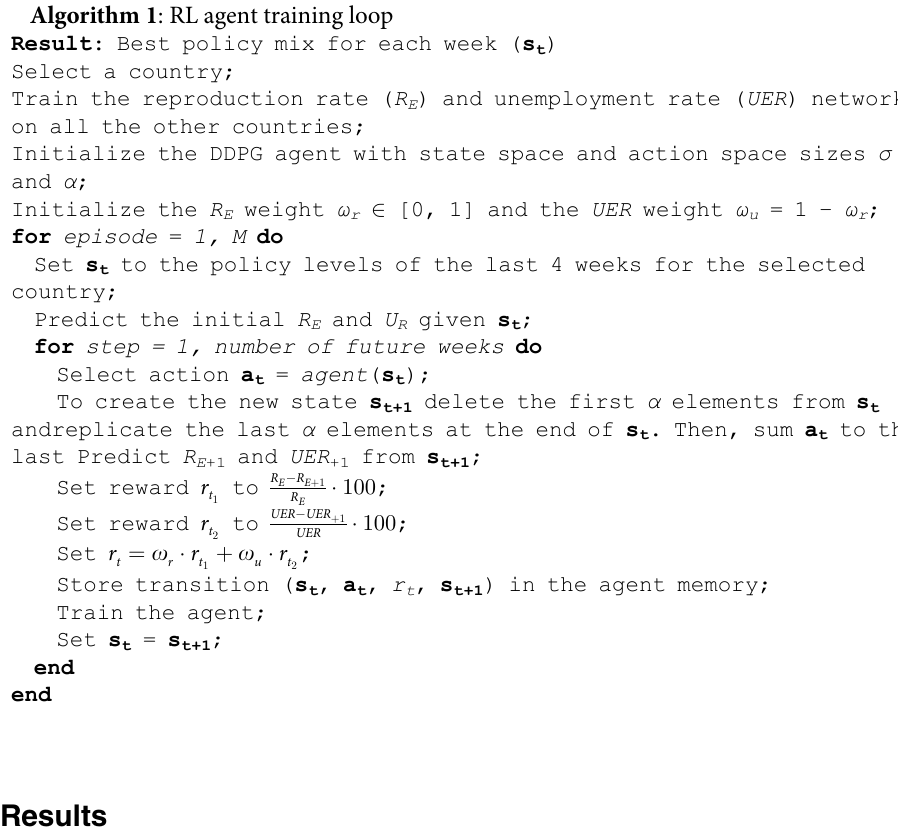
Algorithm 1 : RL agent training